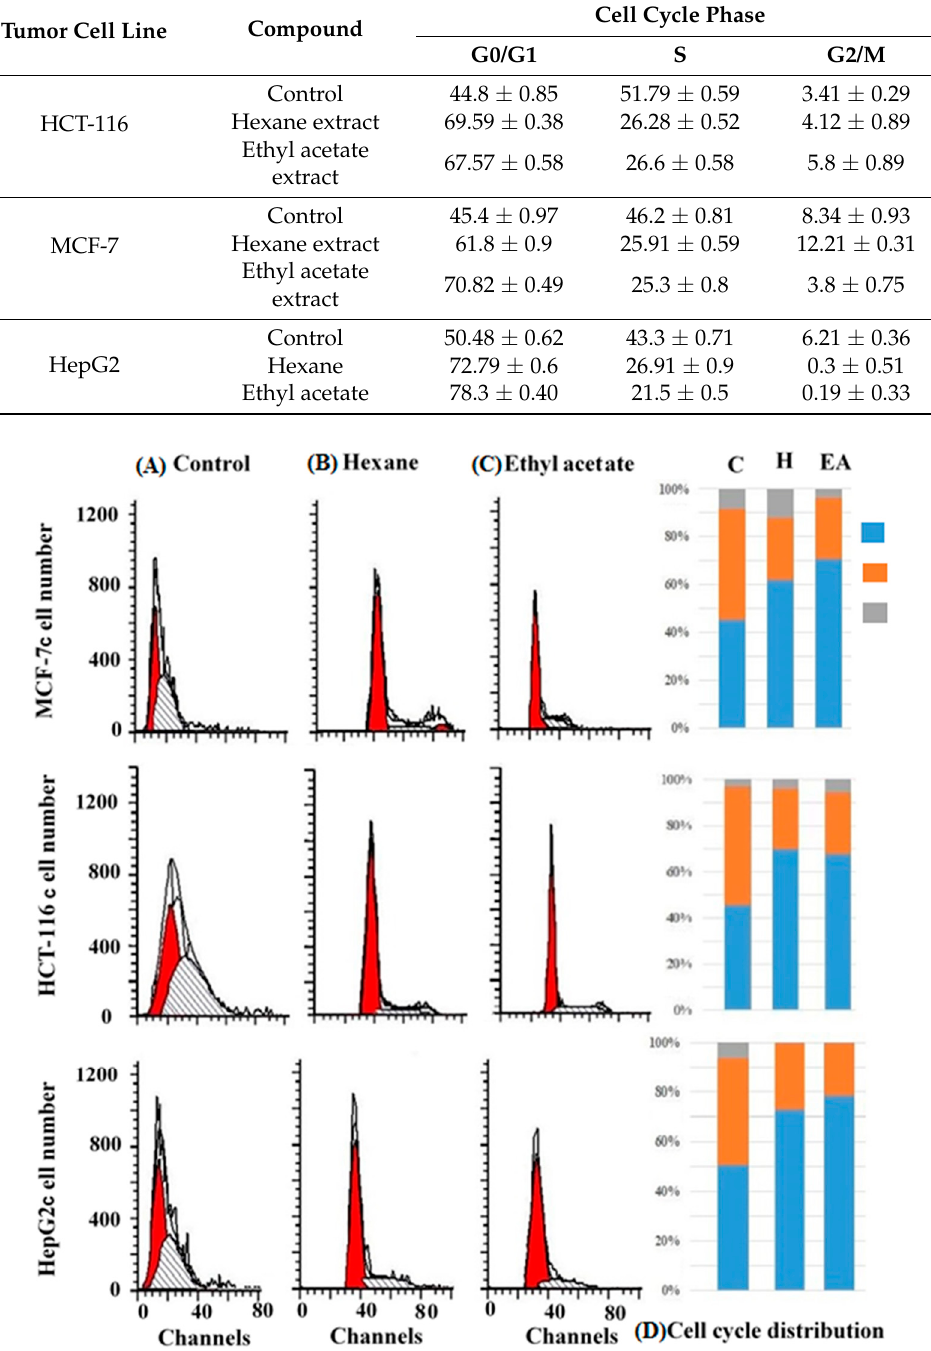
Figure 3. Effect of hexane and ethyl acetate fractions of A. lagopoides aqueous ethanol crude extract on the cell cycle distribution of different cancer cells. Cells were exposed to hexane extract ( B ) and ethyl acetate extract ( C ) for 48 h and compared with cell control ( A ). Cell cycle distribution was determined using DNA cytometry analysis, and different cell phases plotted. ( D ) Percent of total events (n = 3).